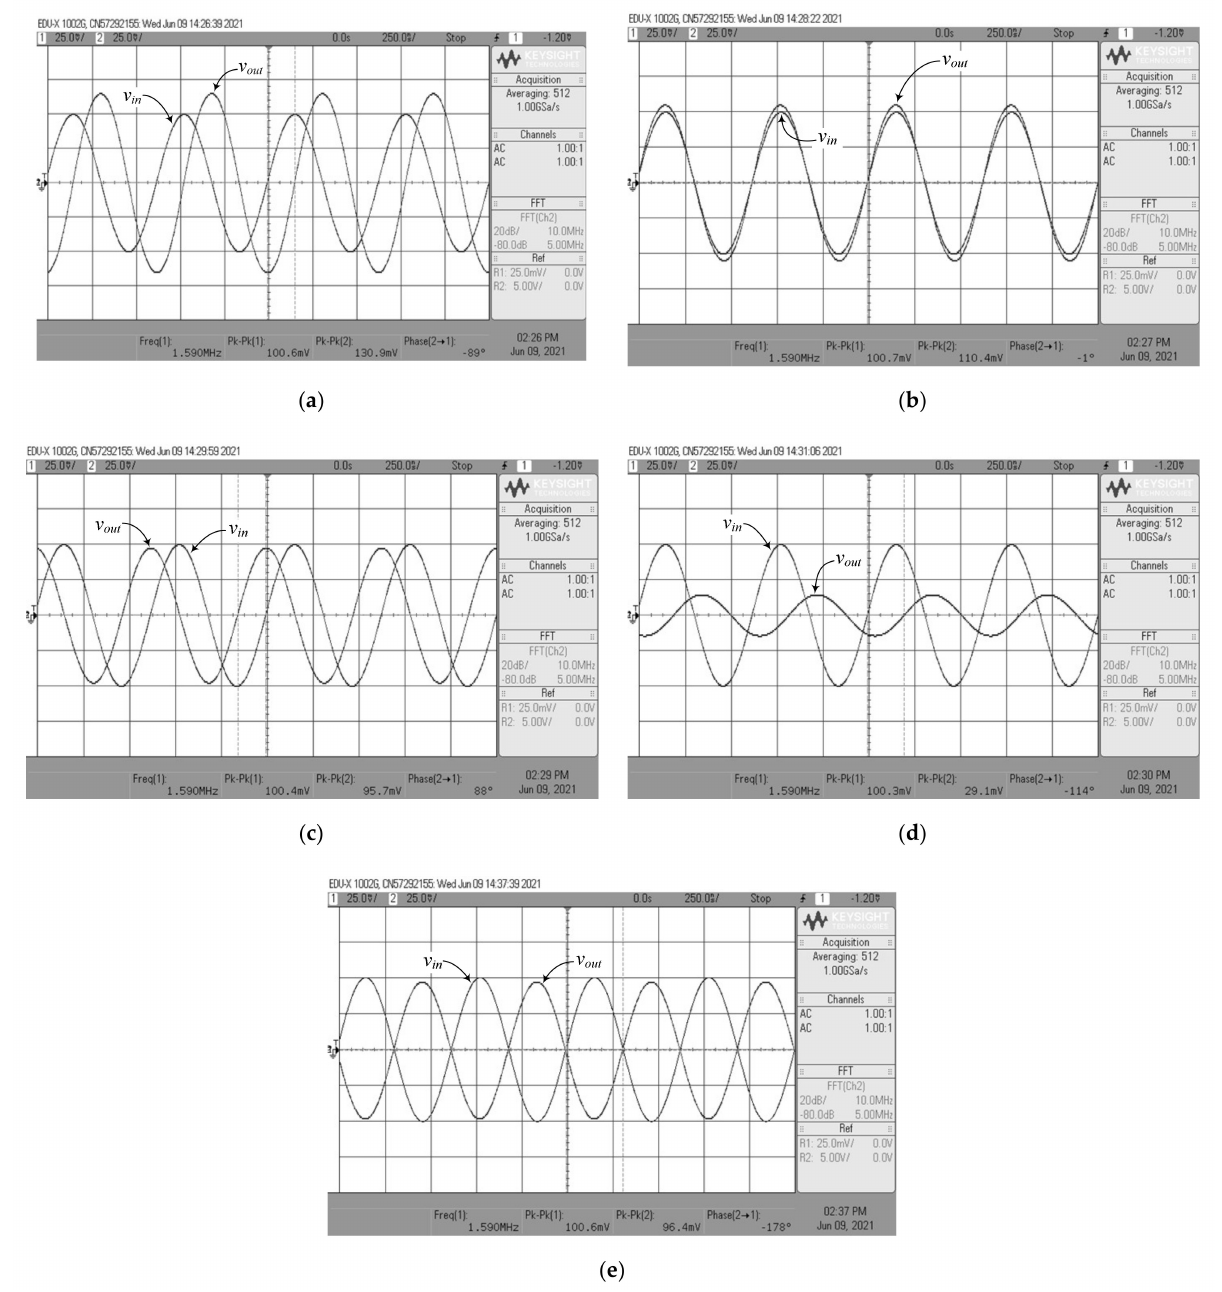
Figure 18. Measured time-domain waveforms of the proposed VM filter: ( a ) LP; ( b ) BP; ( c ) HP; ( d ) BS; ( e )